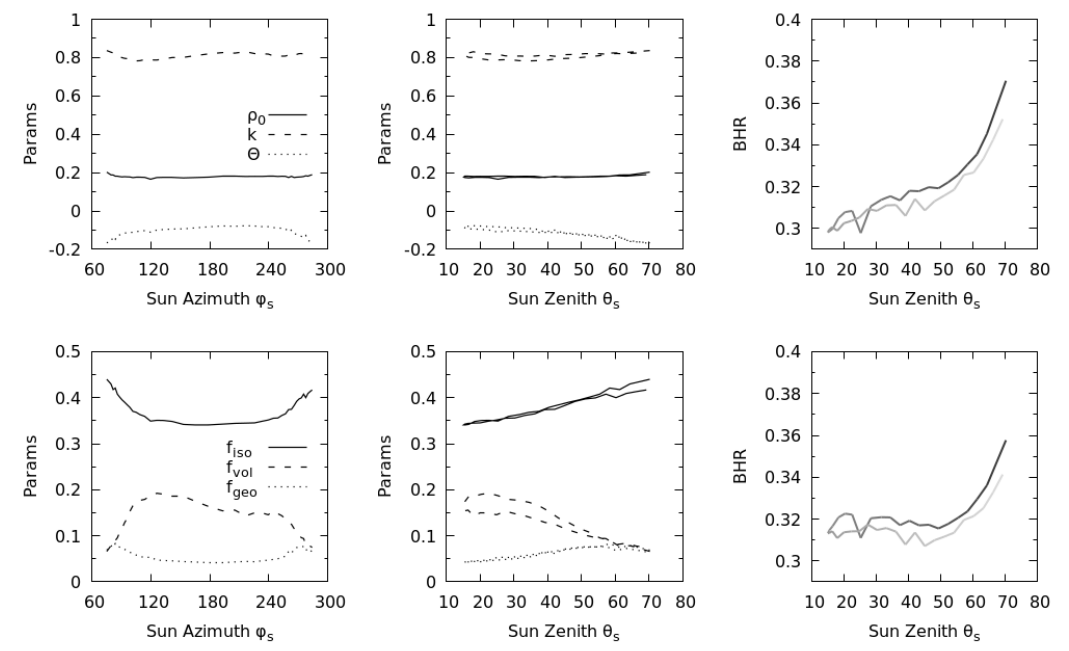
Figure 6. Set-by-set optimization of RPV ( above ) and RTLS ( below ) parameters and the corresponding BHR (rightmost panels) for the green band as recorded on 24 June 2009 by PARABOLA. The retrieved parameters are plotted with respect to φ i ( left ) and θ i ( center ) sun angles, while the BHR is expressed with respect to θ i only ( right ). When plotted with respect to θ s , a pair of points for the same angular conditions that occur in the morning and afternoon is plotted. For the BHR only, morning is marked as darker than afternoon.